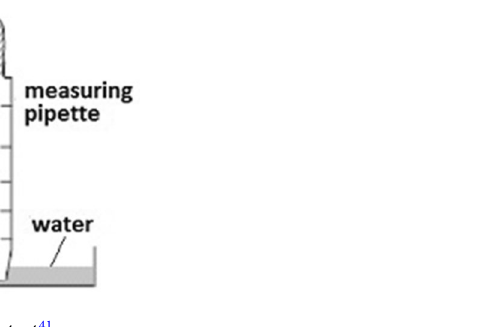
Figure 2. The instrument for the CO 2 evolution test 41